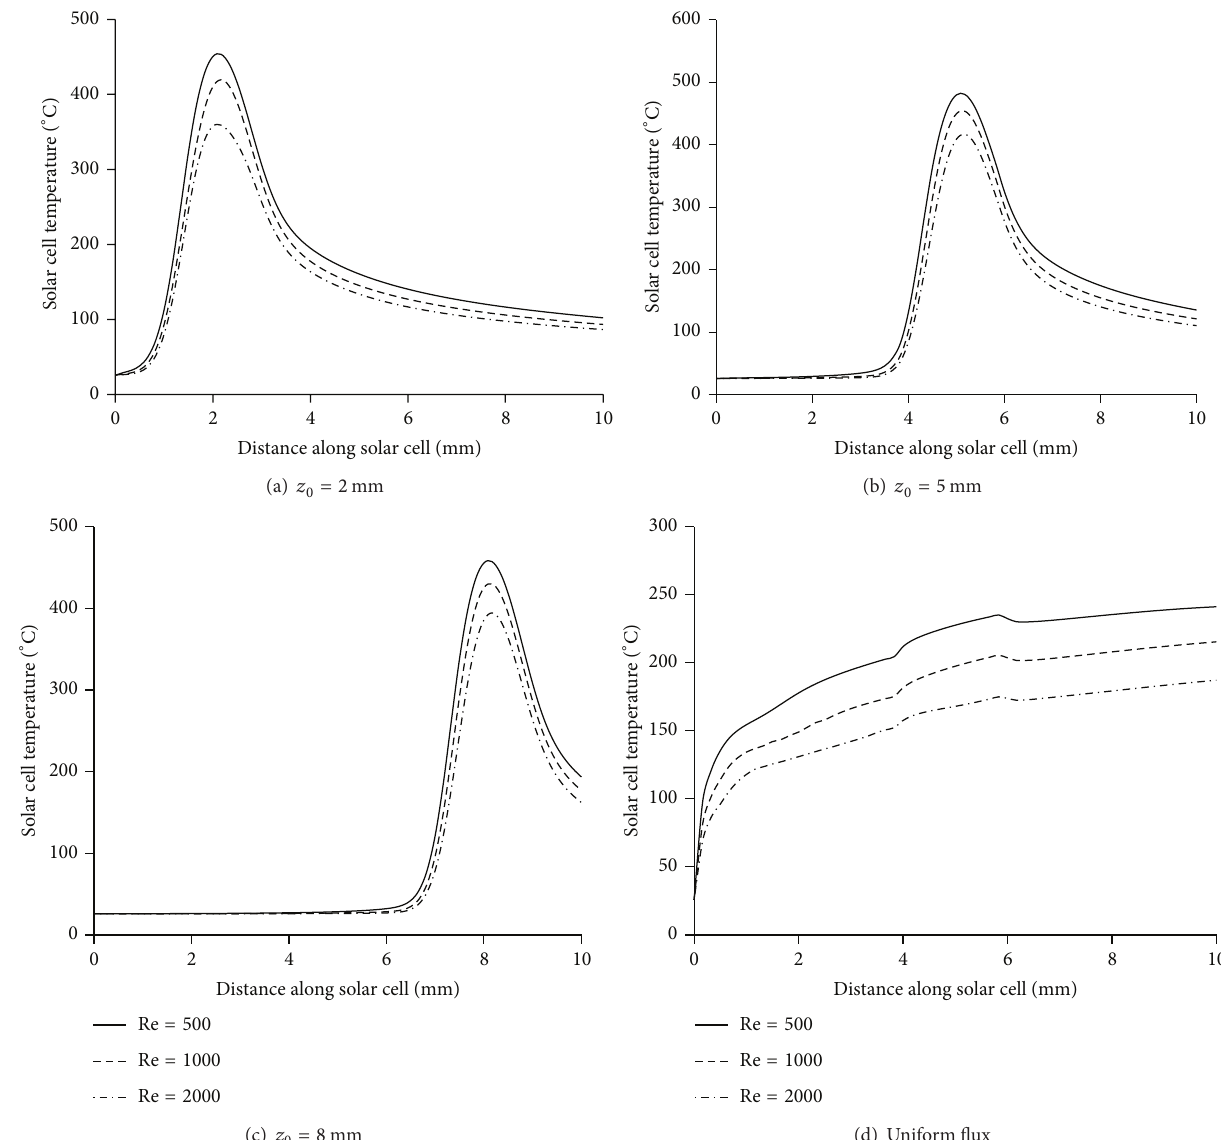
Figure 7: Variations in solar cell temperature obtained using different values of Re, when SD = 0.001, 𝜀 = 0.95 , and 𝐶 = 100 .